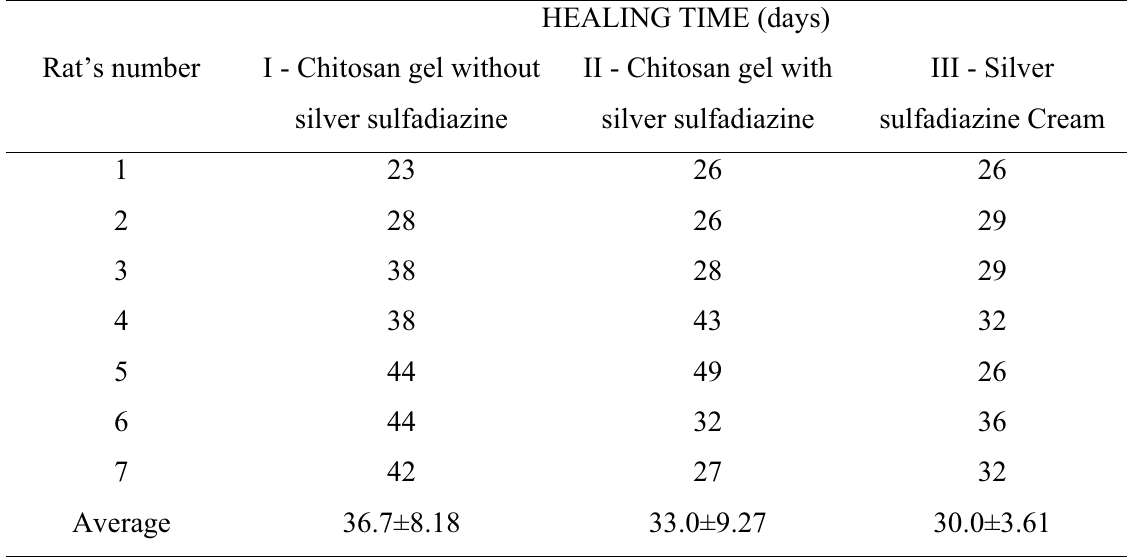
TABLE 1 - Time required for epithelization (healing time) in